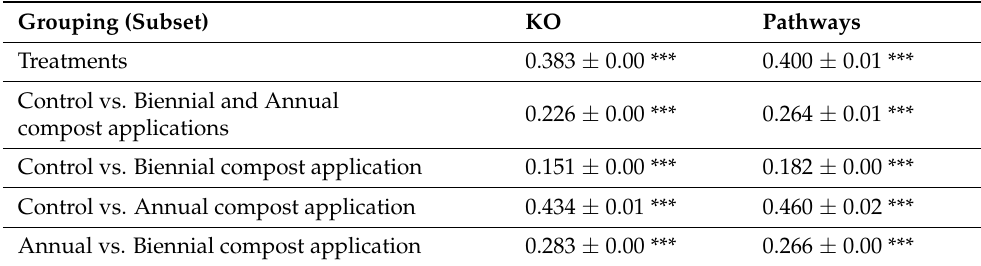
Table 4. Variation in groupings of functions prediction by PICRUSt2 explained by Bray–Curtis distances as affected by frequency of application of municipal solid waste